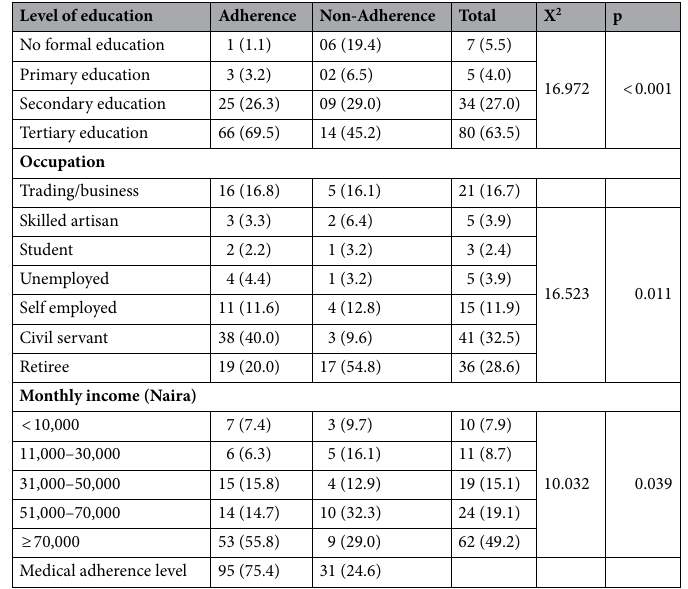
Table 5. Relationship of socio-economic status of respondents with medication adherence strategies of diabetes mellitus. Values in parenthesis indicate % while X 2 and p represent chi-square and probability values, respectively.